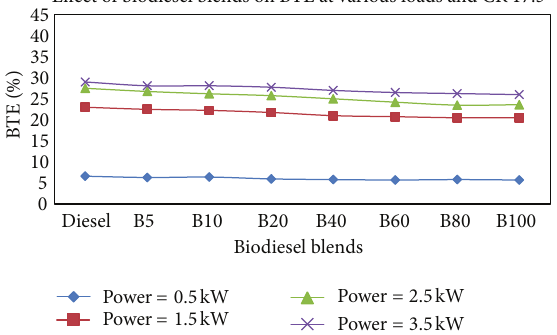
Figure 7: Variation in BTE for various biodiesel blends at different